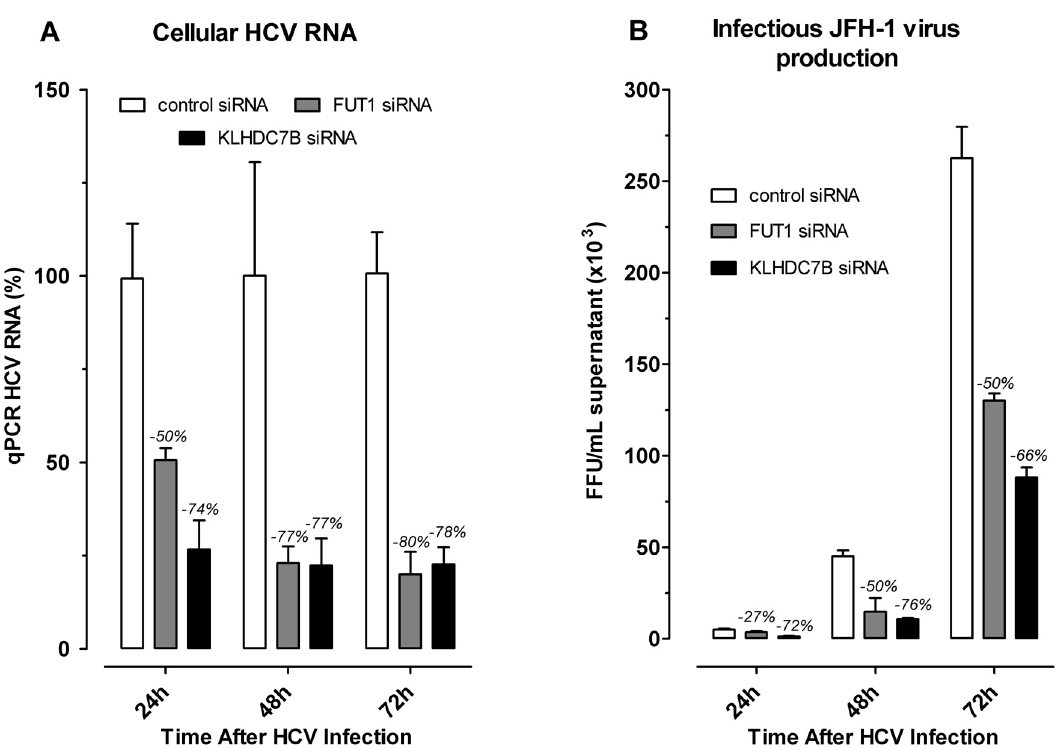
Figure 9 . siRNA silencing of FUT1 and KLHDC7B inhibit HCV replication and infectious virus production. Huh 7.5 cells were transfected with control siRNA (white bars), FUT1 (gray bars) or KLHDC7B (black bars) and infected with JFH-1 (MOI = 0.5) for two hours, supplemented with fresh complete DMEM and continuously cultured to 24, 48, and 72 hours. At each time point, HCV RNA was measured by real-time PCR ( A ) and the titer of infectious HCV was measured by serial dilution of culture supernatants ( B ). The percent inhibition produced by each siRNA is shown above each bar in the